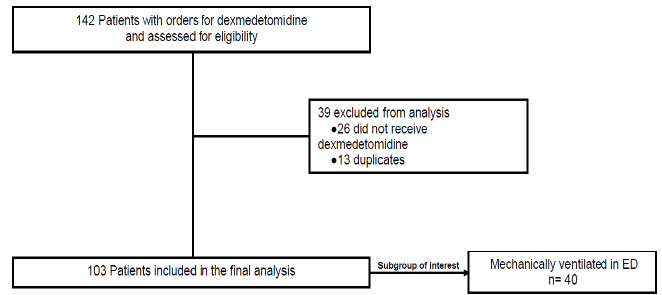
Figure 1. Flow diagram of included patients who had orders for